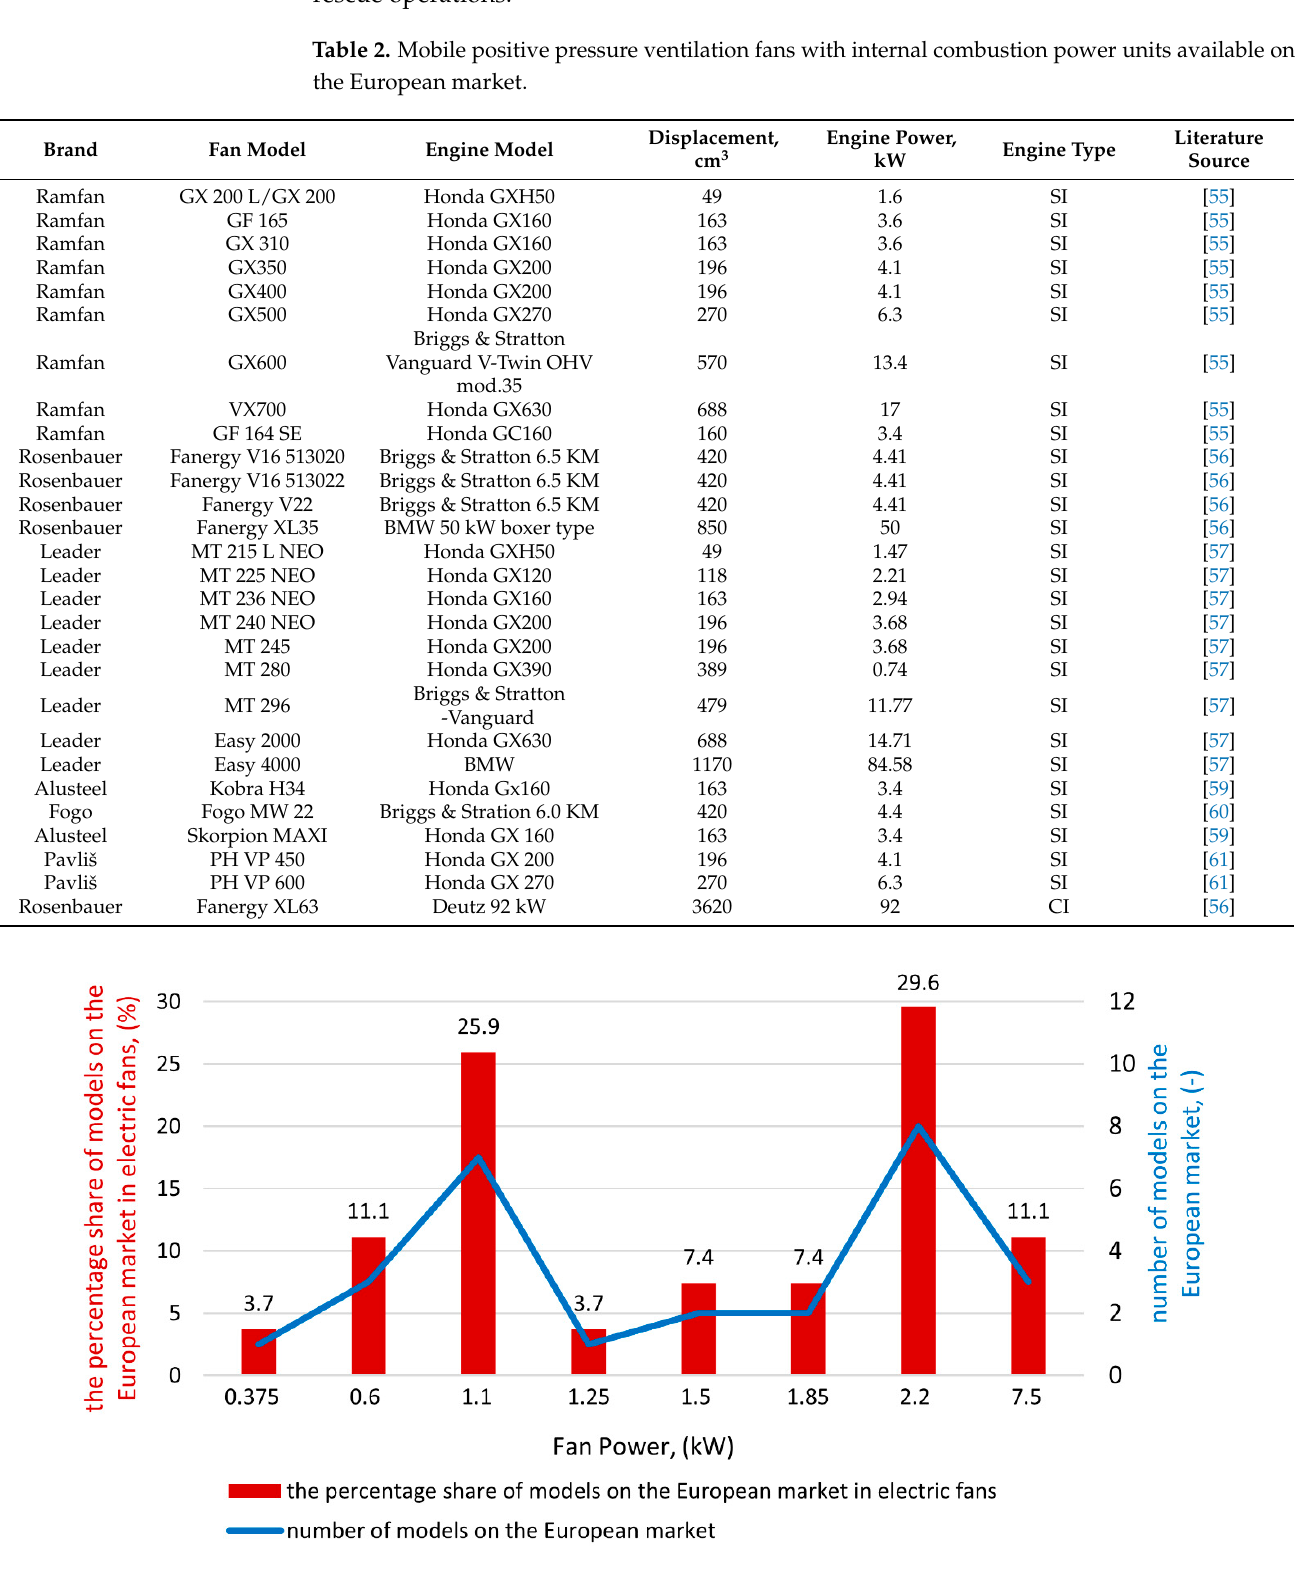
Figure 2. Fans with an internal combustion engine on the European market.